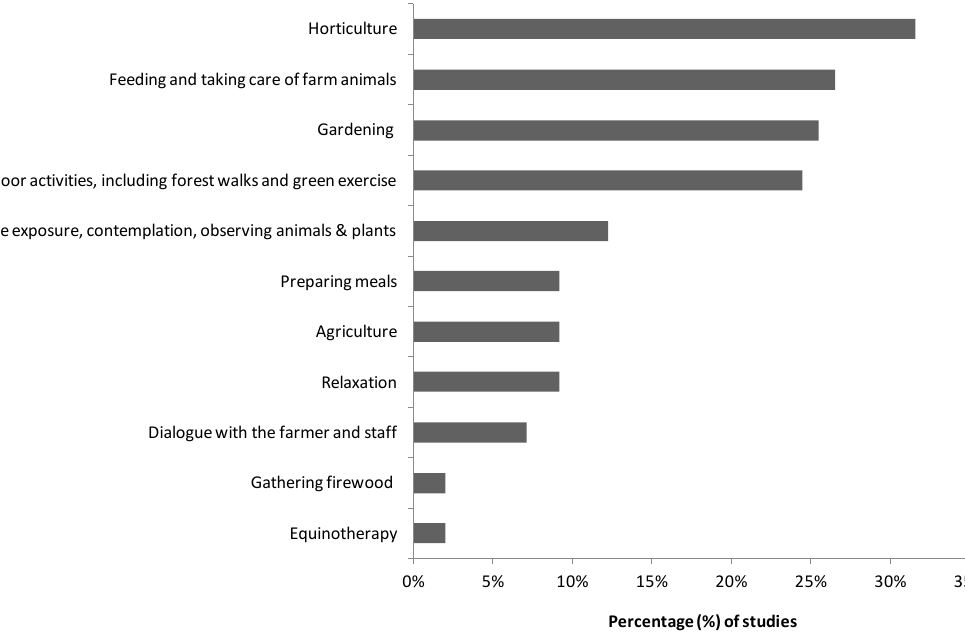
Figure 5. Green care activities carried out during interventions.